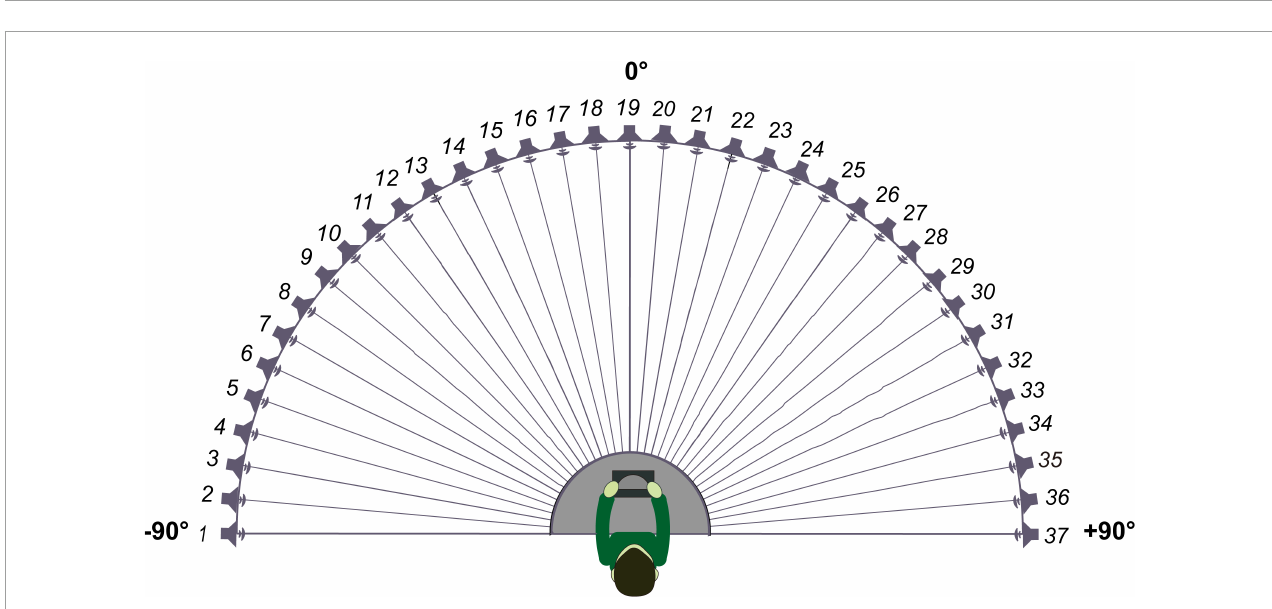
FIGURE2 Schematic diagram of loudspeaker